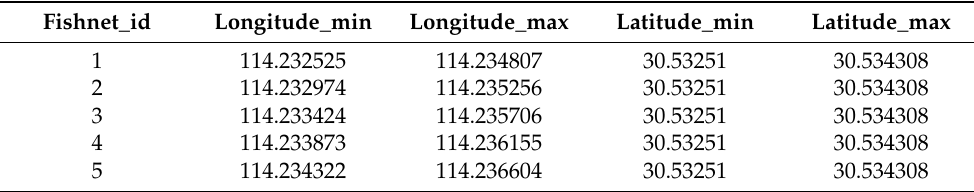
Table 3. Map grid information table data